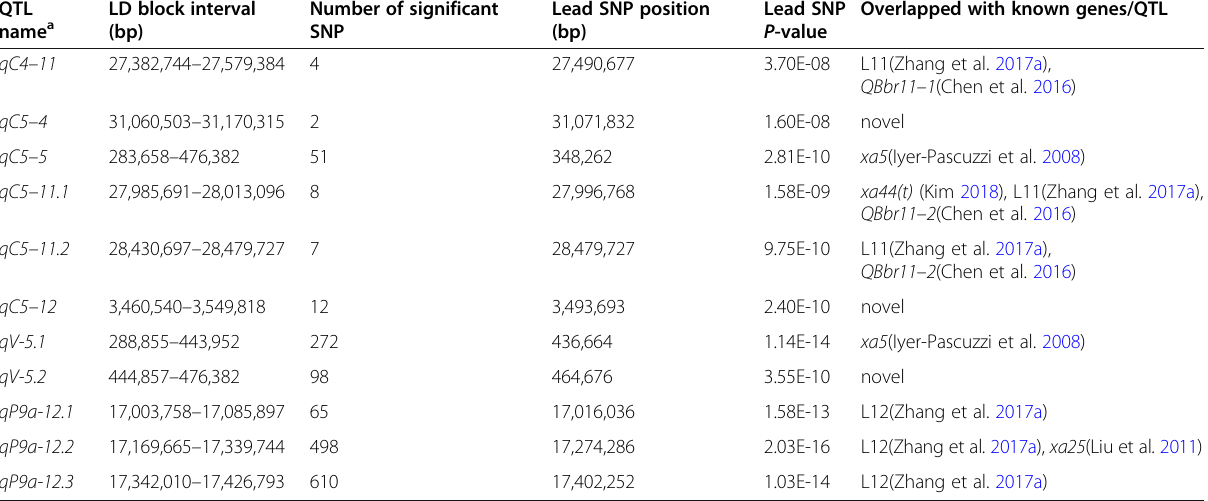
Table 1 Significant loci for rice bacterial blight resistance obtained from genome-wide association study QTL name